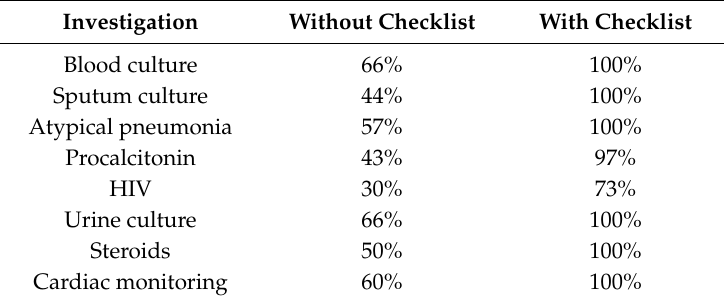
Figure 1. Key data before and after checklist implementation. Table 1. Data with and without checklist.